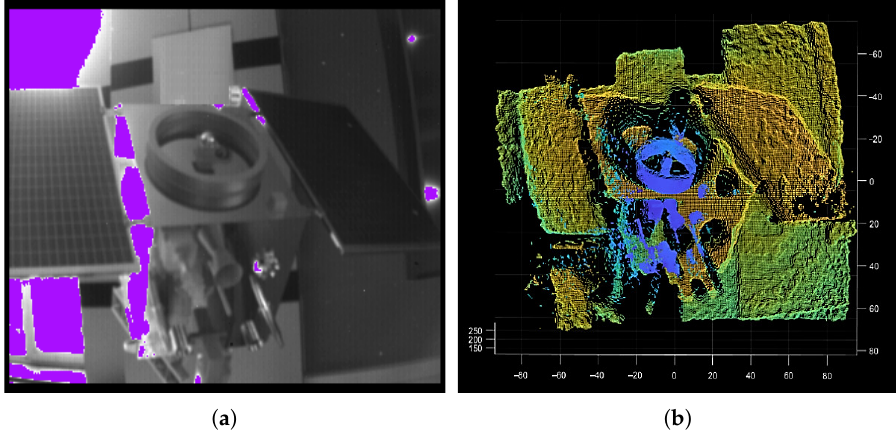
Figure 2. Data of Time-of-Flight (ToF) camera. ( a ) The captured gray image; ( b ) The captured point cloud in the field of view (76,800 points). Obviously, the circle feature only accounts for a small part of the point